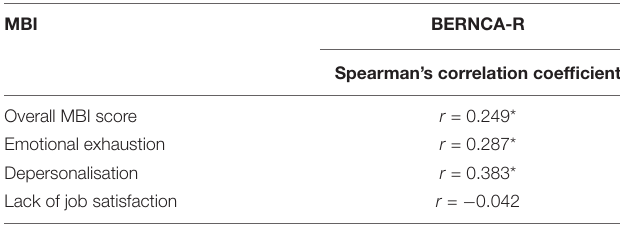
TABLE 3 | Correlations between professional burnout and rationing of nursing